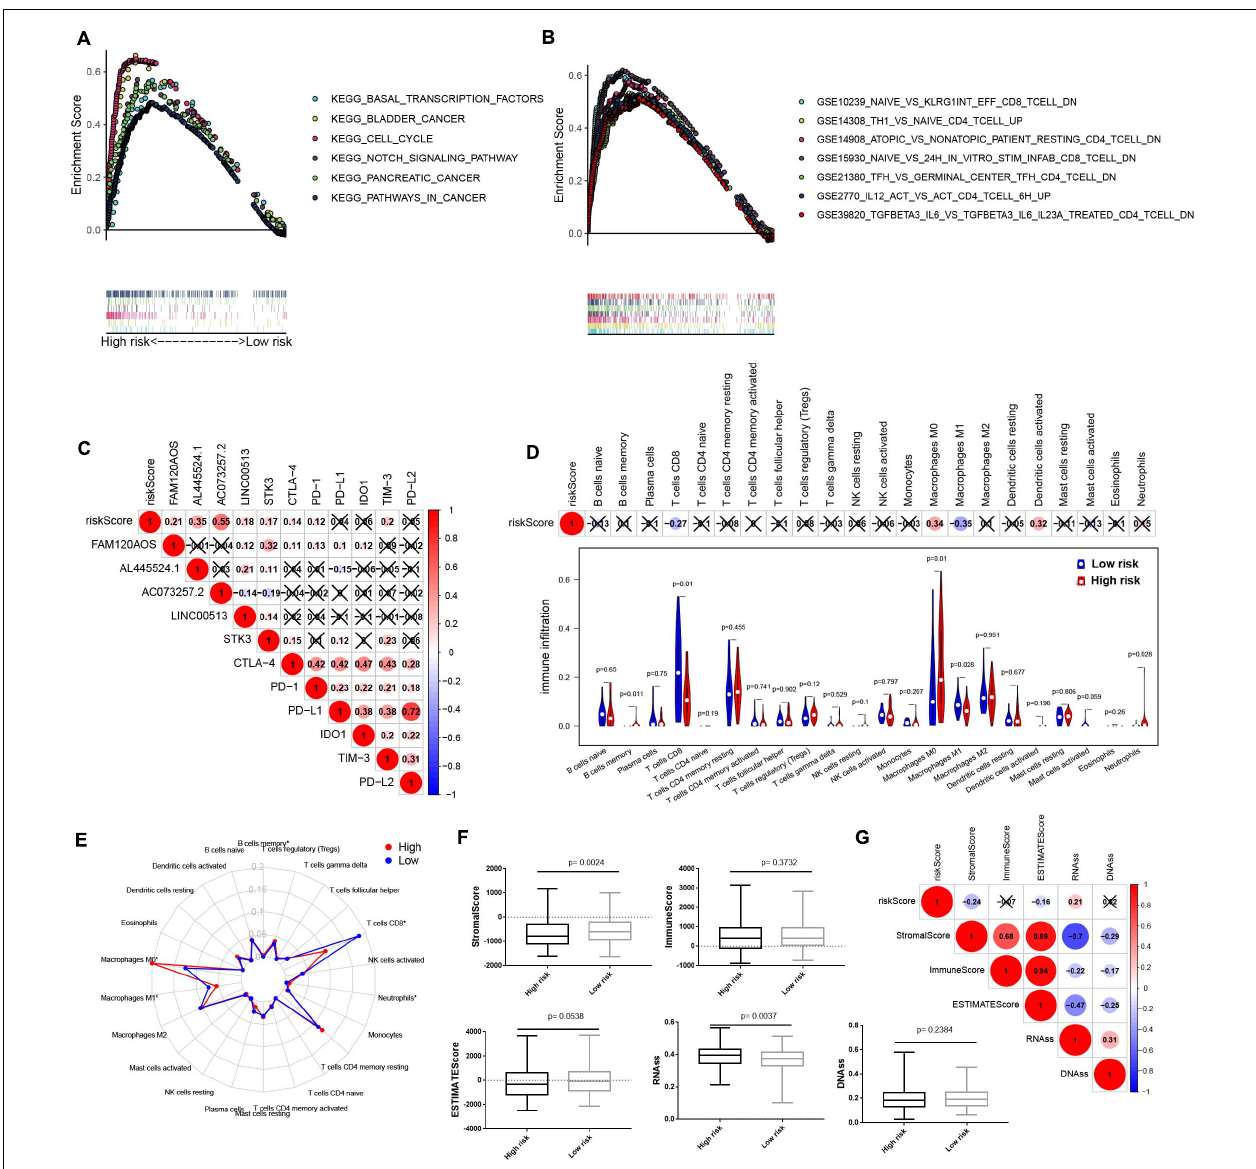
FIGURE 6 | IReRS GSEA and relationship with immune checkpoint and immune cell infiltration. (A) Six cancer hallmarks were significantly enriched in the high-risk patients. (B) Seven immune signatures were significantly enriched in the high-risk patients. (C) Associations between immune-related eRNA signature and immune checkpoint genes were detected. Violin plot (D) , Radar map (E) were used to display the differences of the infiltrating immune cells in HCC patients between high- and low-risk groups. Boxplot (F) and correlation heat map (G) illustrated the correlations of risk score to immunoscore and tumor stem cell in HCC.